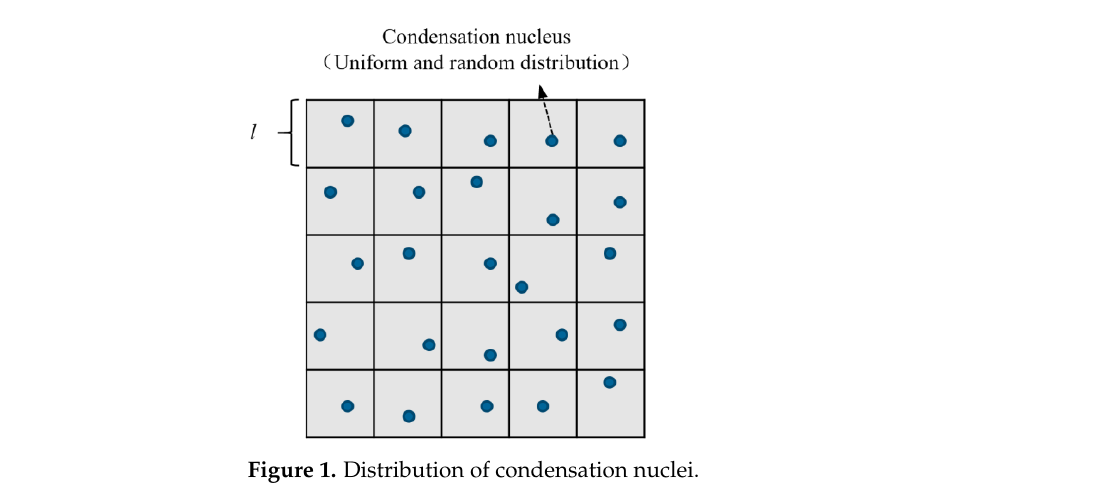
represents the spatial position of the condensation nuclei,